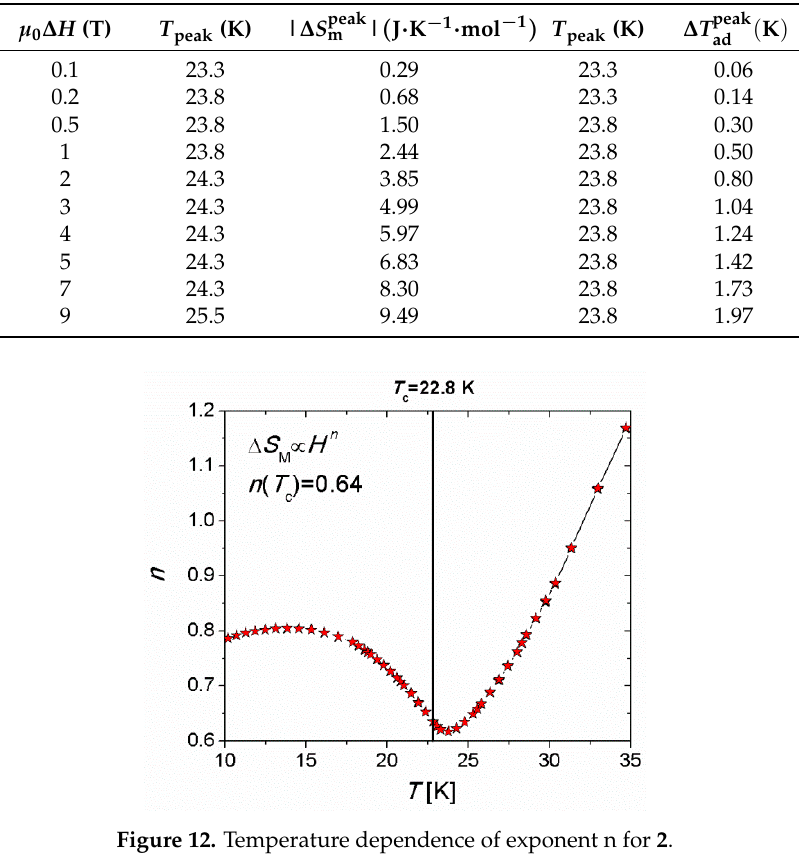
Table 2. Peak values of ∆ S m and ∆ T ad of 2 .